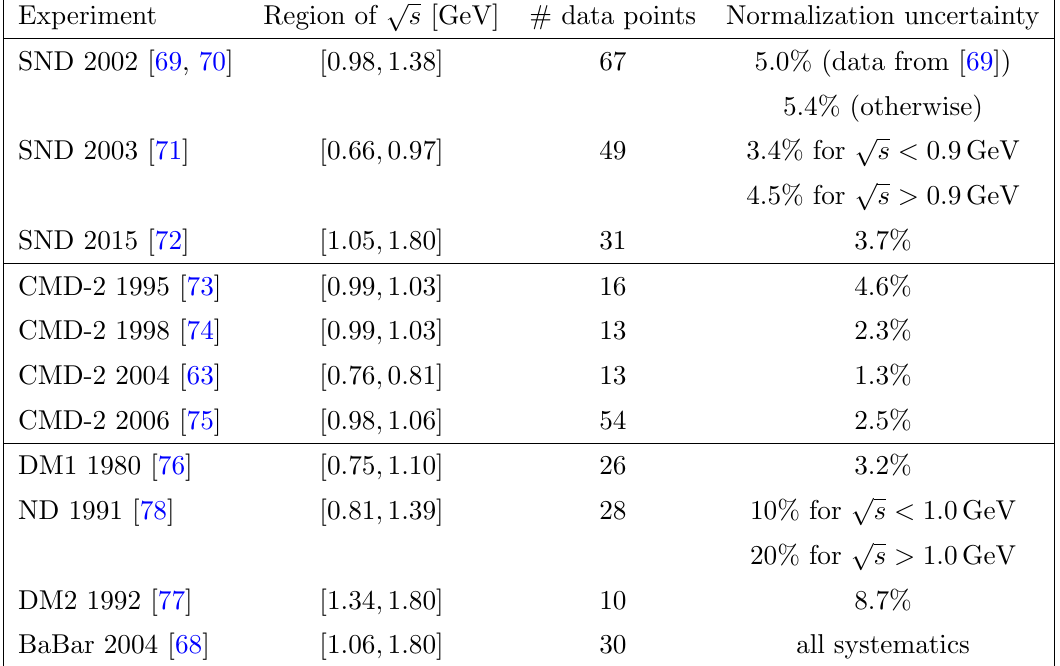
Table 1 . Summary of data sets for e + e (cid:0) are included. In the last column we indicate the size of the systematic errors that we interpret as a normalization-type uncertainty and therefore assume to be 100%